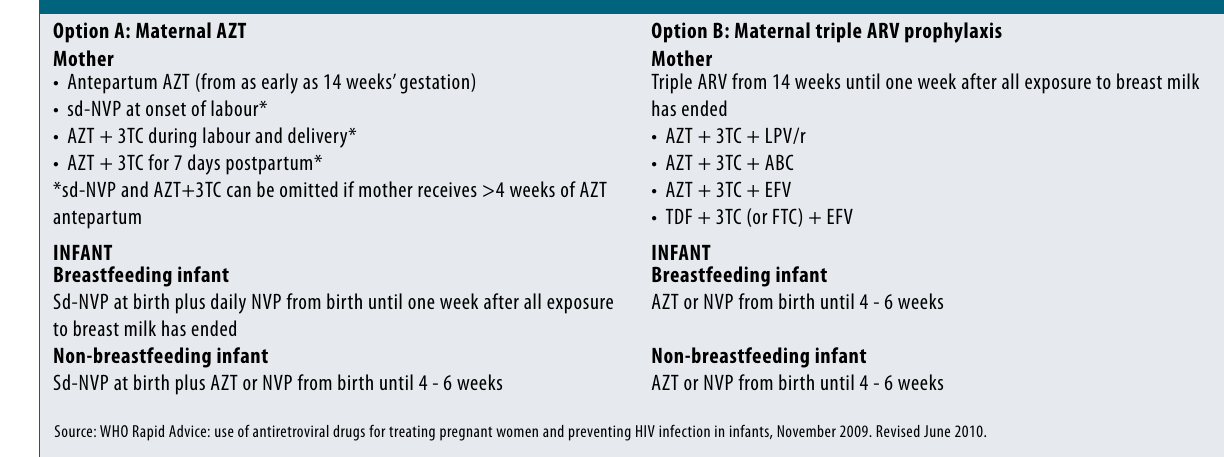
taBle 1. arv prophylaXIs optIons recommenDeD for hIv-InfecteD pregnant women who Do not neeD treatment for theIr own health